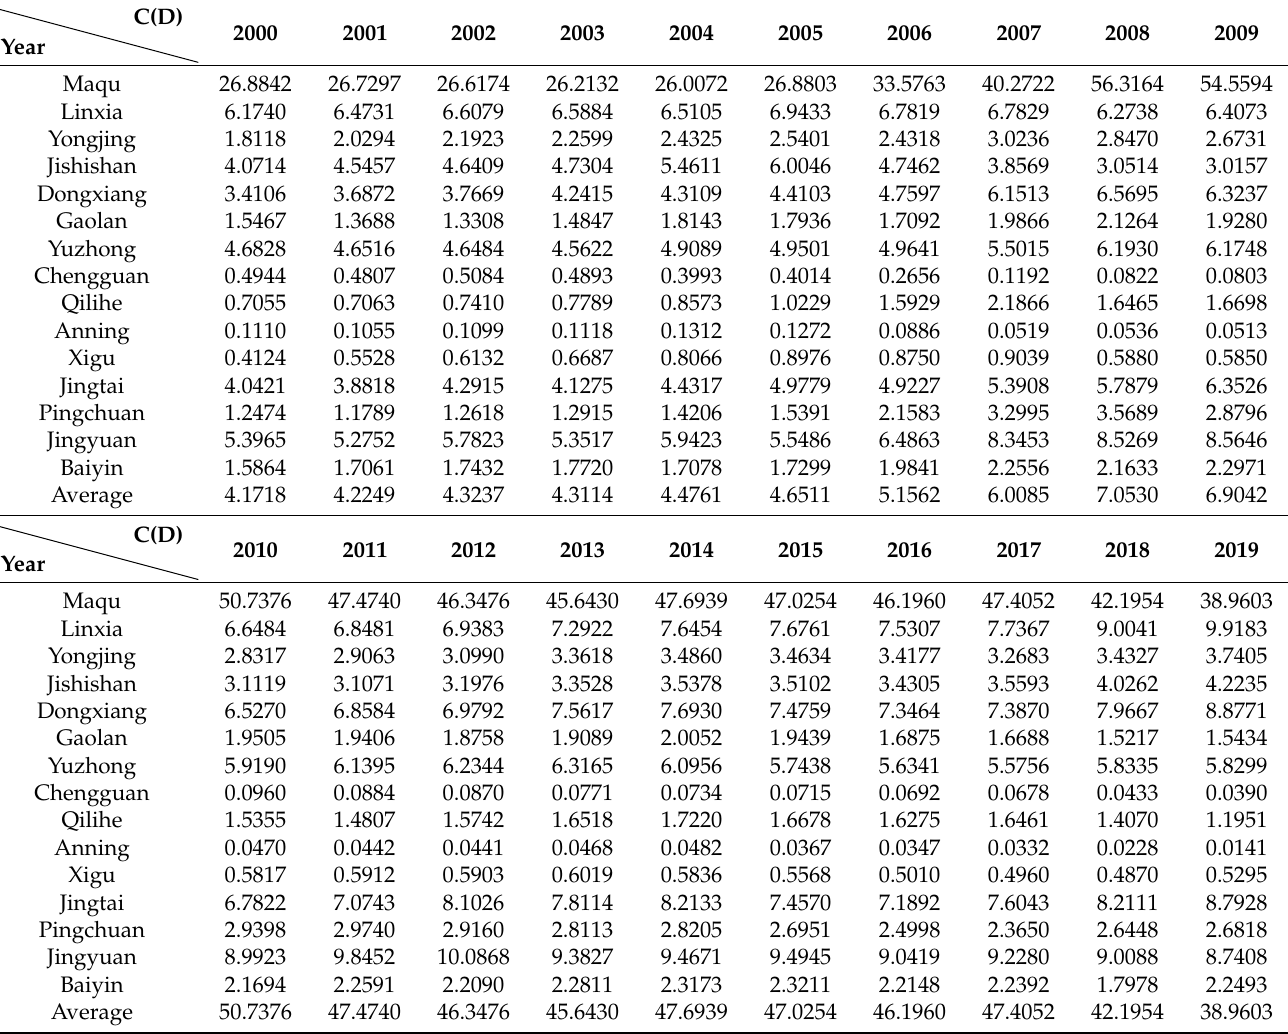
Table 2. The total GHG emissions in the 15 county (district) of Gansu section of the Yellow River Basin from 2000 to